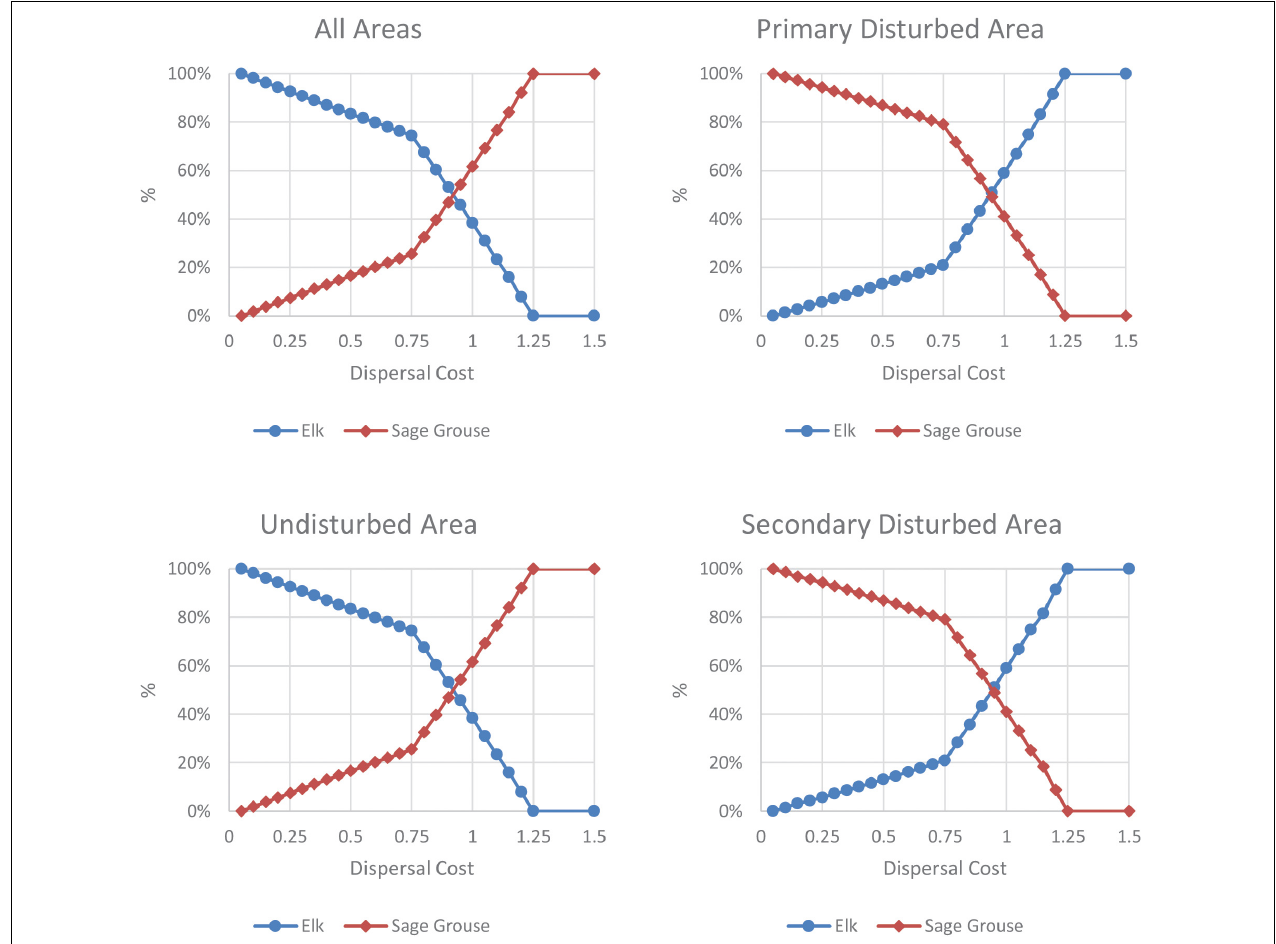
FIGURE 4 | Population distribution after development across dispersal costs. For the landscape and each sub-area, the graphs depict the percentage of the maximum population for elk and sage grouse at the post-disturbance steady state across dispersal costs in the complex model. The graphs are normalized such that 100% is the highest possible population and 0% is the lowest possible population at the post-development steady state in each area for that species. This normalization relates to the highest and lowest possible populations in each location; it does not imply that a species population goes to zero in an area nor does it imply that species population is not hurt by